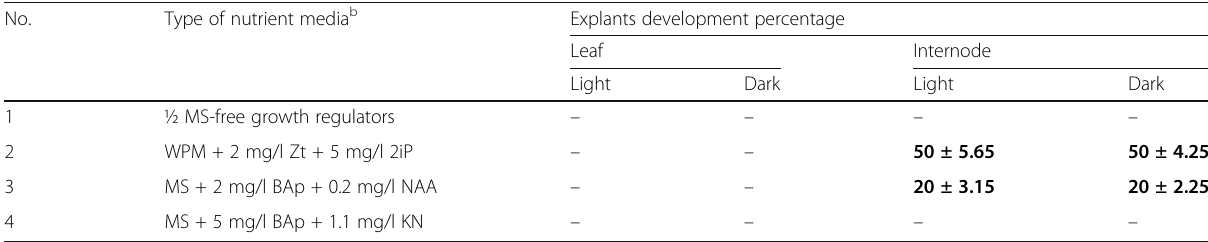
Table 1 Effect of different type of nutrient media on development a percentage of leaf and internode explants of Diospyros kaki L. cv. Costata